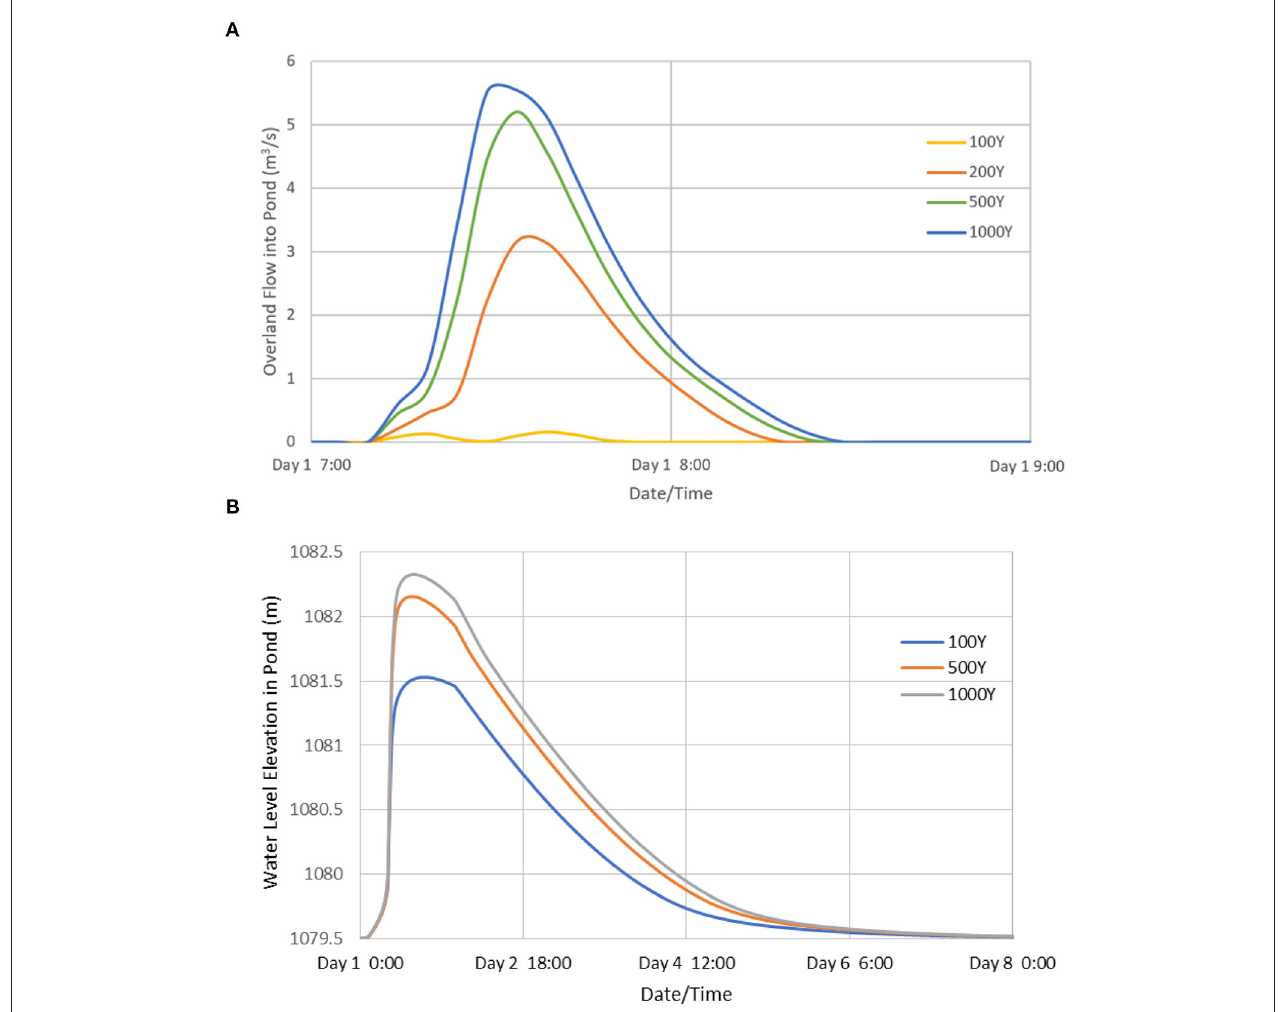
FIGURE 9 | (A) Overland Flow into Storm Pond and (B) Water Levels in Storm